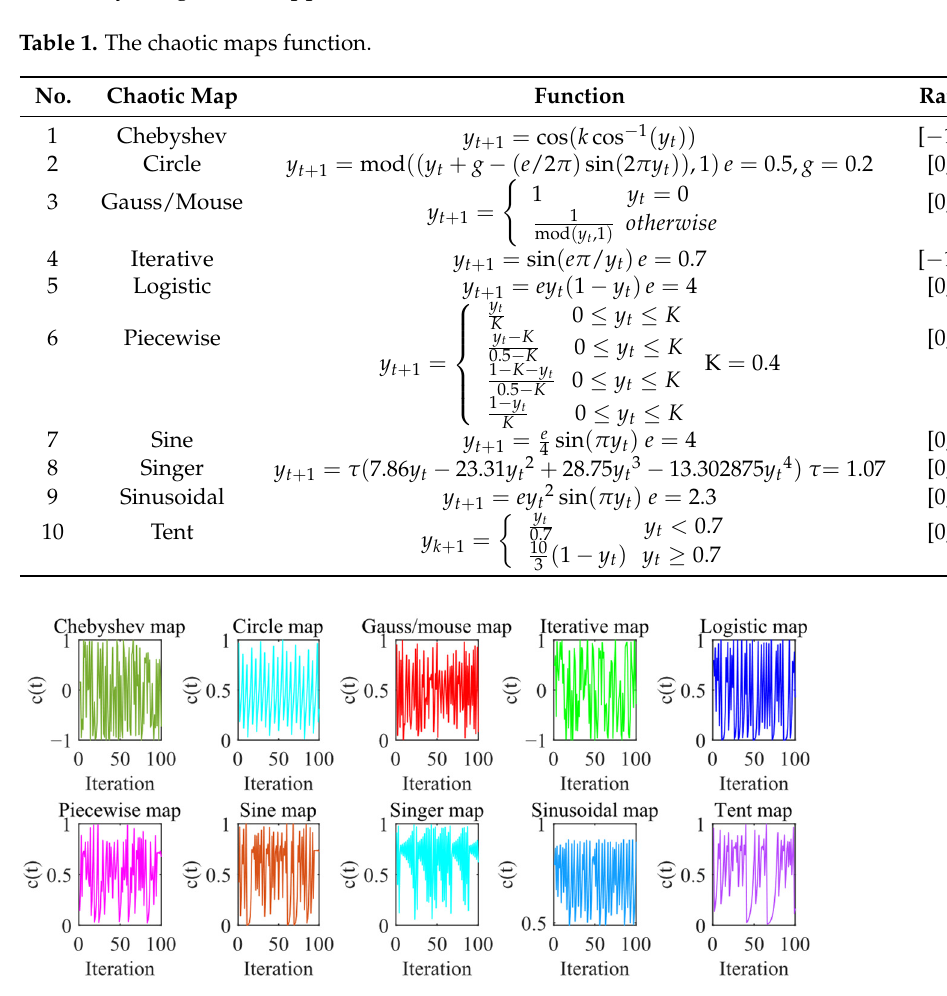
Table 1. The chaotic maps function.